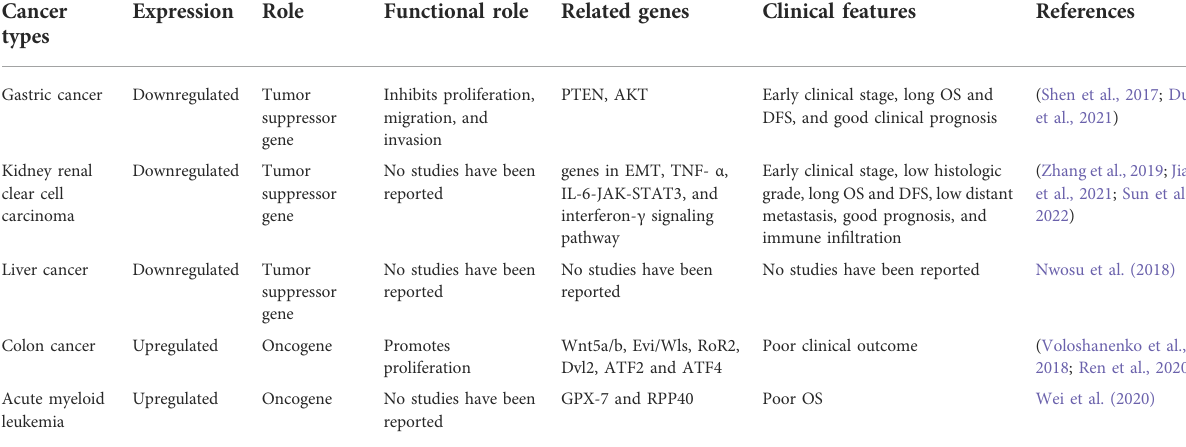
TABLE 1 Functional characteristics and clinical features of HADH in human